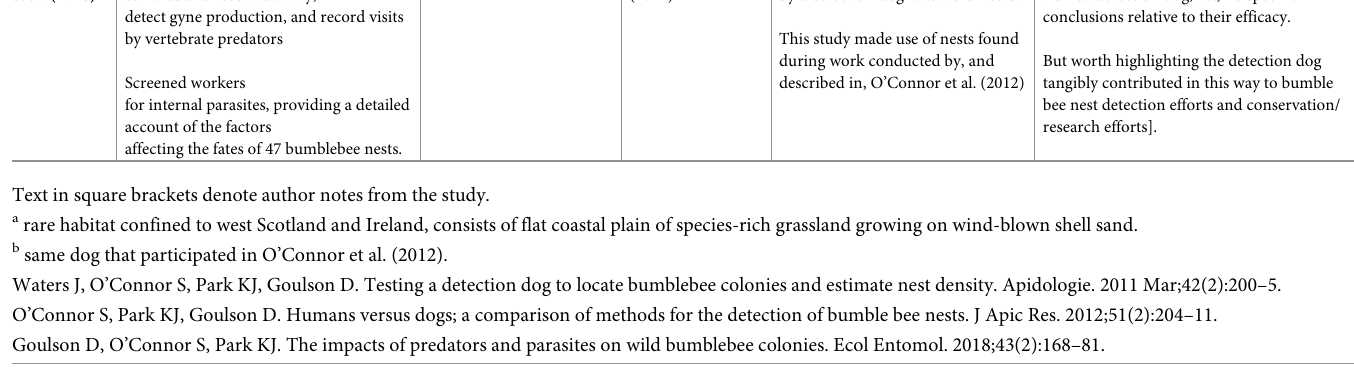
S2 Table. A comparison of historical average (1981–2010) and 2019 temperature and pre- cipitation data for a weather station located in Georgetown, Ontario. (Georgetown